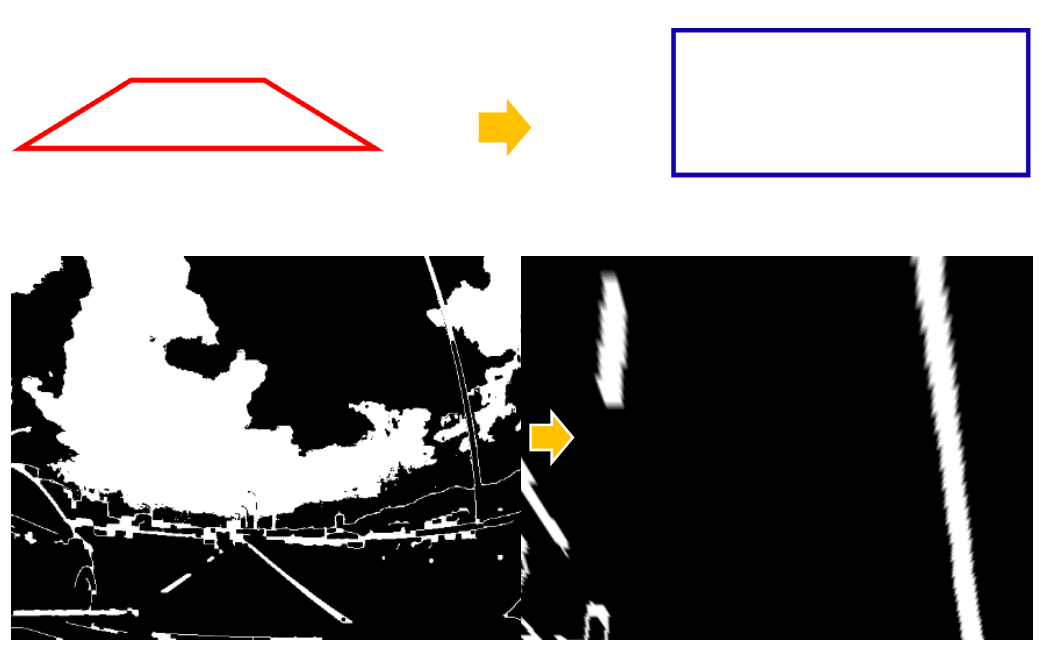
Figure 14. The process of projection transformation.